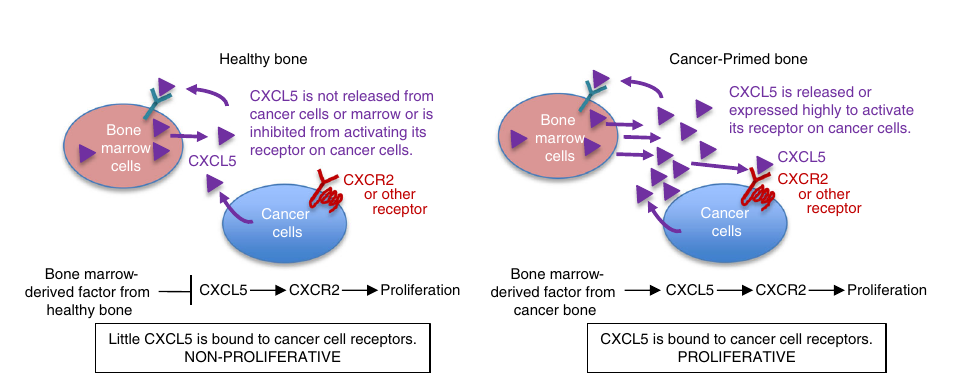
Fig. 5 Model of CXCL5/CXCR2 in metastatic bone colonization. Proposed model of the dormancy switch to colonization by CXCL5/CXCR2 axis in cancer cells. Bone marrow cells from healthy bone produce factors that act as sponges for or inhibit CXCL5, making CXCL5 unavailable for binding to its receptor on cancer cells and activating proliferation, thus causing the cancer cells to remain quiescent. In contrast, cancer-primed bone either inhibits or does not produce the factors that inhibit CXCL5. CXCL5 binds and activates its receptor on the cancer cells, ultimately inducing cancer cell proliferation and colonization at the bone metastatic